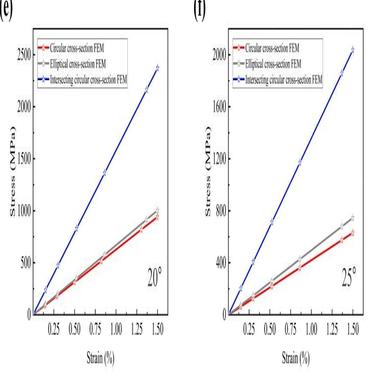
Comparison of stress–strain responses of carbon fiber tows in finite element simulations for three models with twist angles from 0◦ to 25◦.